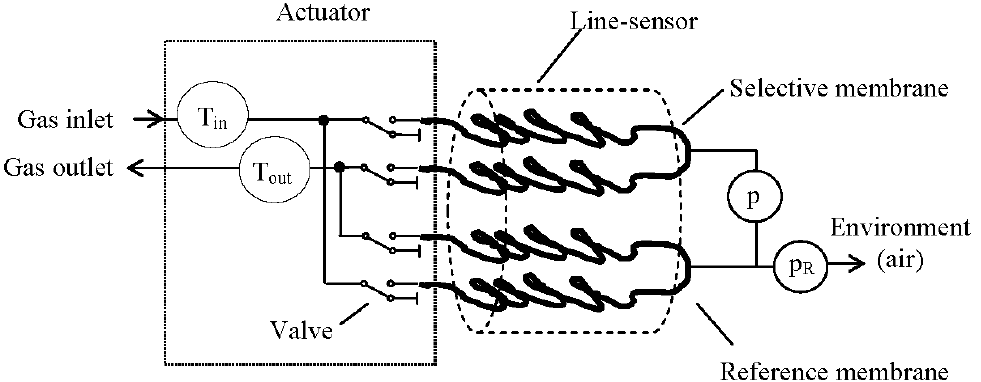
Figure 1. Measurement set-up: for flushing the line-sensor, an actuating unit, containing sensors (T , T ) for registration of the reference gas temperature and four valves, in out connects the line-sensor with a gas supply. The line-sensor is composed of a selective membrane and a reference membrane. The concentration sensitive pressure change p ( t ) and the reference pressure p ( t ) were measured at the half-length of the flow paths within the R sensor